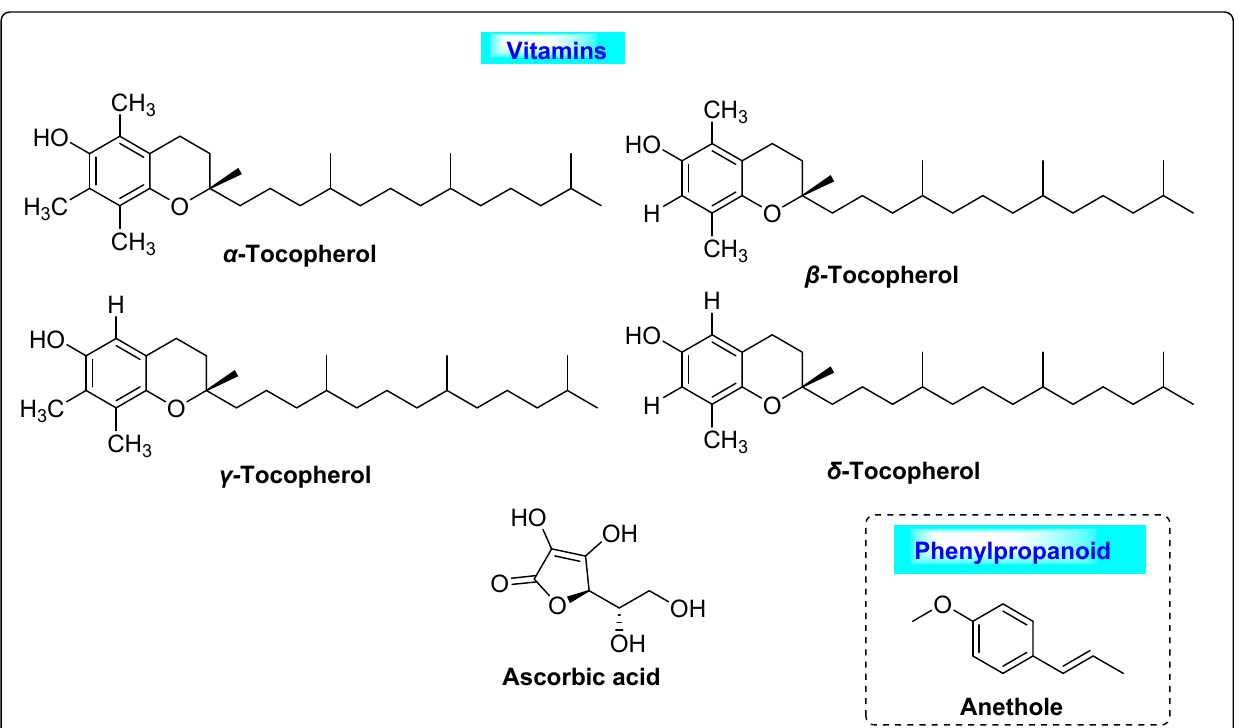
Figure 13. Vitamins and phenylpropanoids of Foeniculum vulgare that possess usefulness in PCOS.